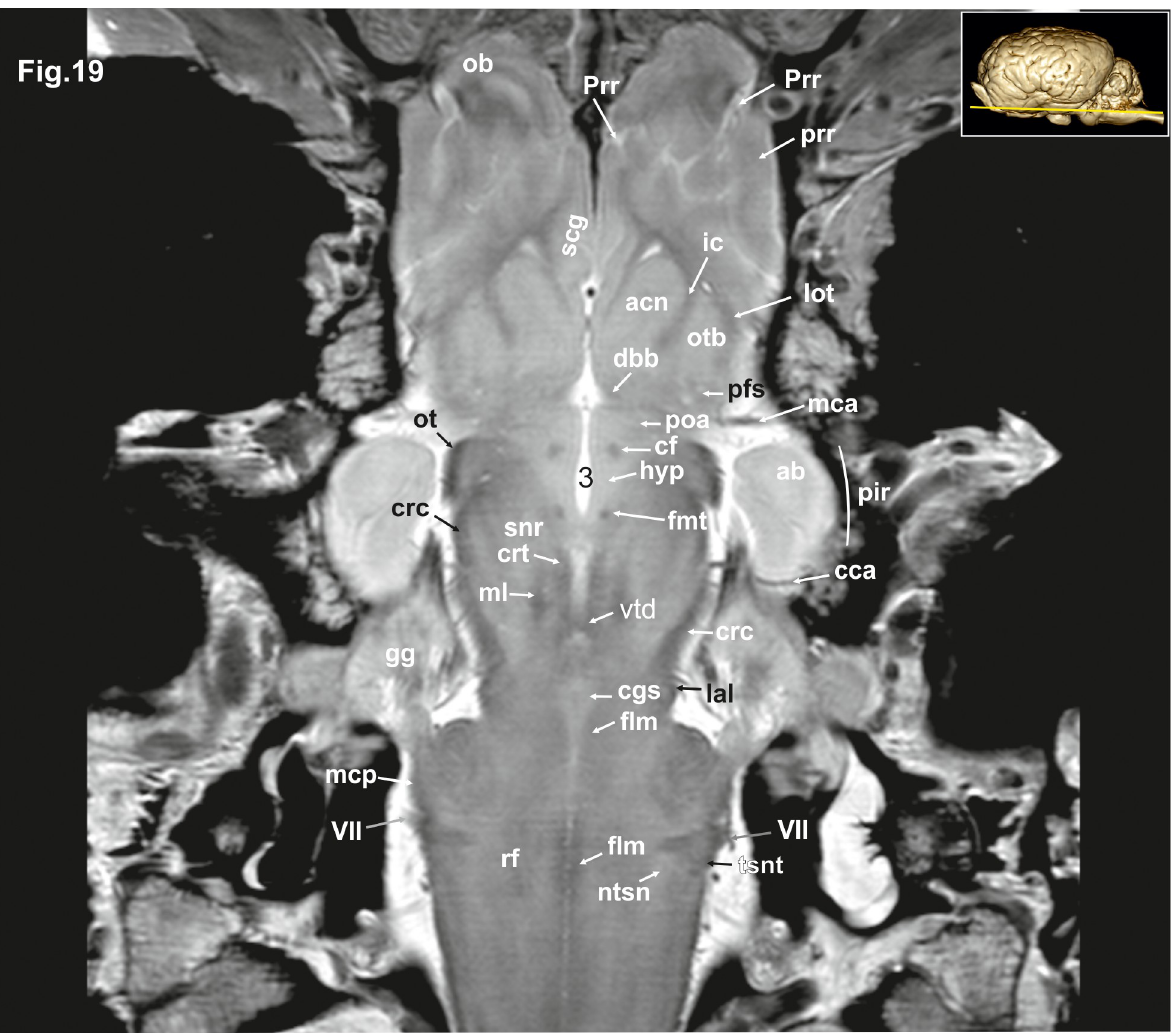
Fig 19. Dorsal magnetic resonance image of the equine brain on the level of the amygdaloid nuclei. ab: amygdaloid body, acn: accumbens nucleus, cca: caudal cerebral artery, cf: column of fornix, cgs: central grey substance, crc: cerebral crus, crt: rubro-cerebello-thalamic tract, dbb: diagonal band of broca, flm: medial longitudinal fasciculus, fmt: mammilo-thalamical fasciculus, gg: Gasserian ganglion, hyp: hypothalamus, ic: internal capsule, IaI: lateral lemniscus, lot: lateral olfactory tract, mca: medial cerebral artery, mcp: medial cerebellar peduncle, ml: medial lemniscus, ntsn: nucleus of the spinal tract of the trigeminal nerve, ob: olfactory bulb, ot: optic tract, otb: olfactory tubercle, pfs: perforated substance, pir: piriform lobe, poa: preoptic area, prr: prorean gyrus, Prr: prorean sulcus, rf: reticular formation, scg: subcallosal gyrus, snr: substantia nigra, tsnt: spinal tract of the trigeminal nerve, vtd: ventral tegmental decussation, VII: facial nerve, 3: third ventricle.